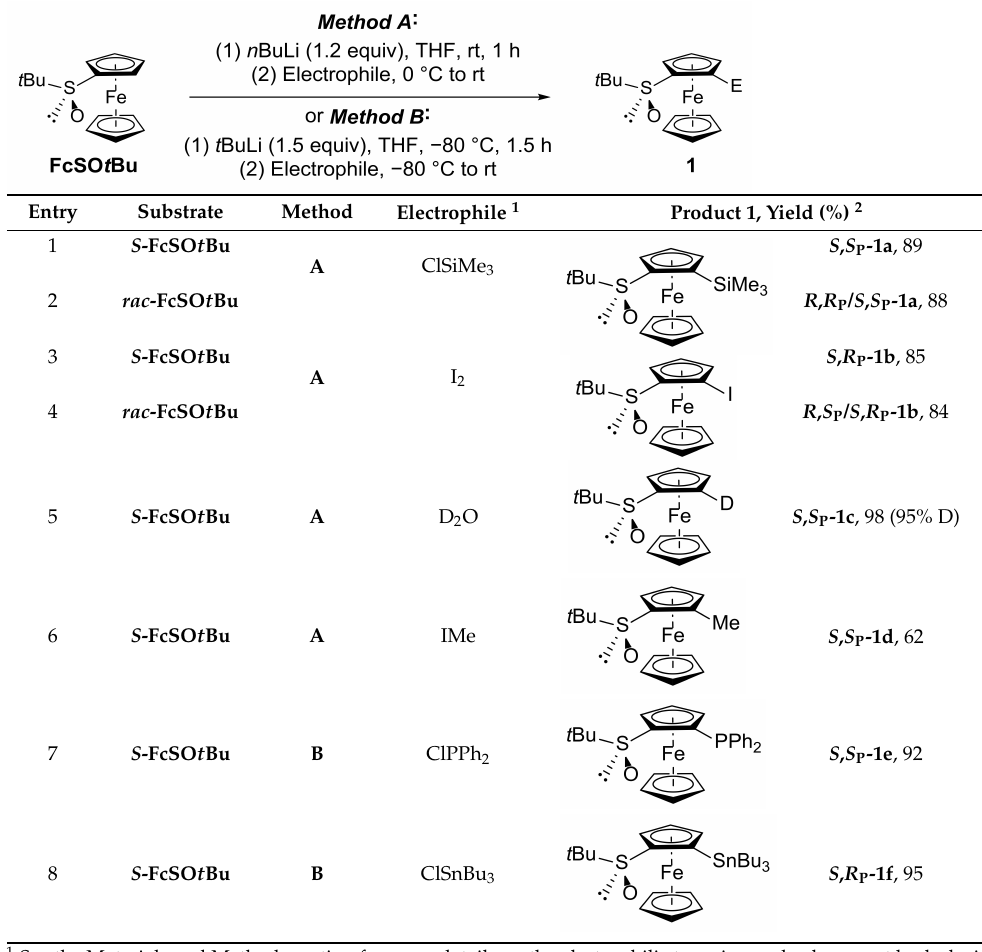
Table 1. Deprotometalation of S - tert -butylferrocenesulfoxides followed by electrophilic